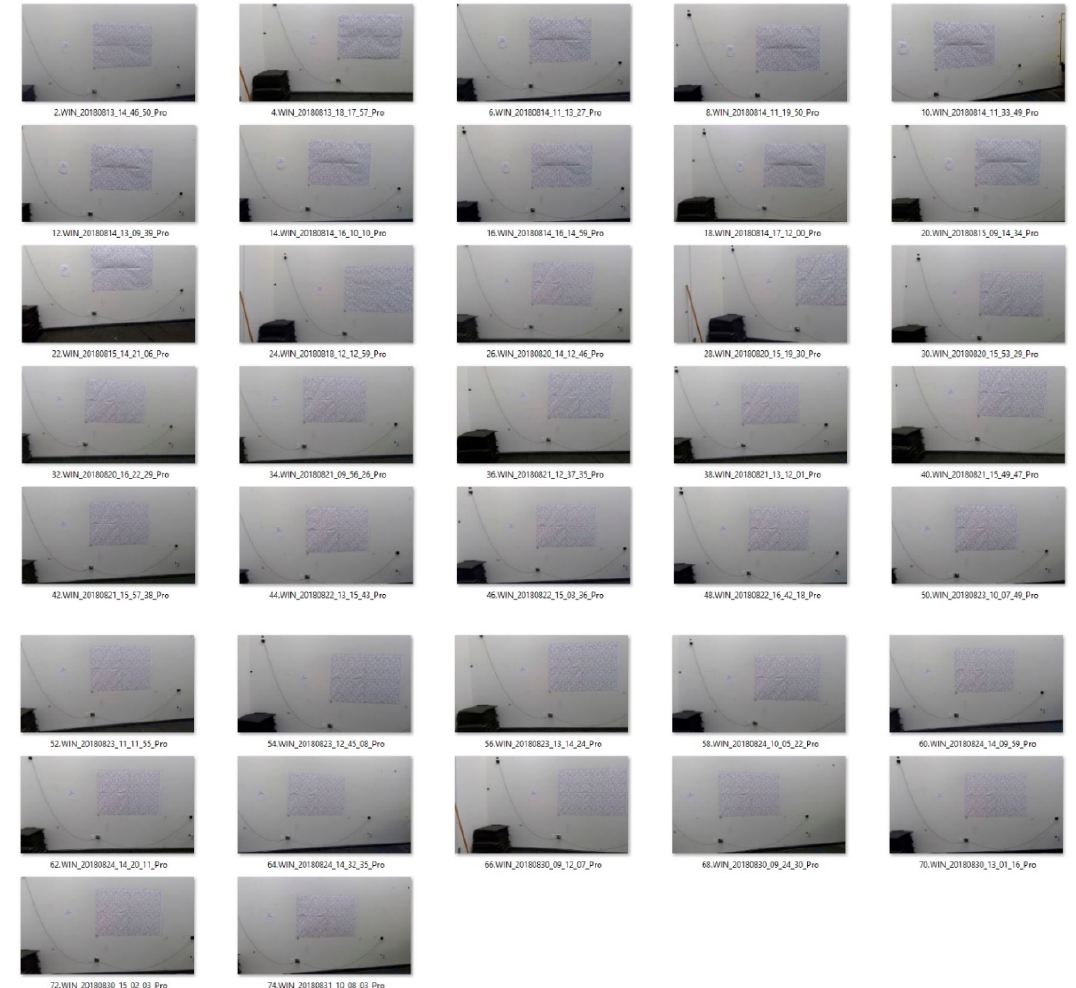
Figure 21. The second sample group of pictures. Figure A3. The second sample group of